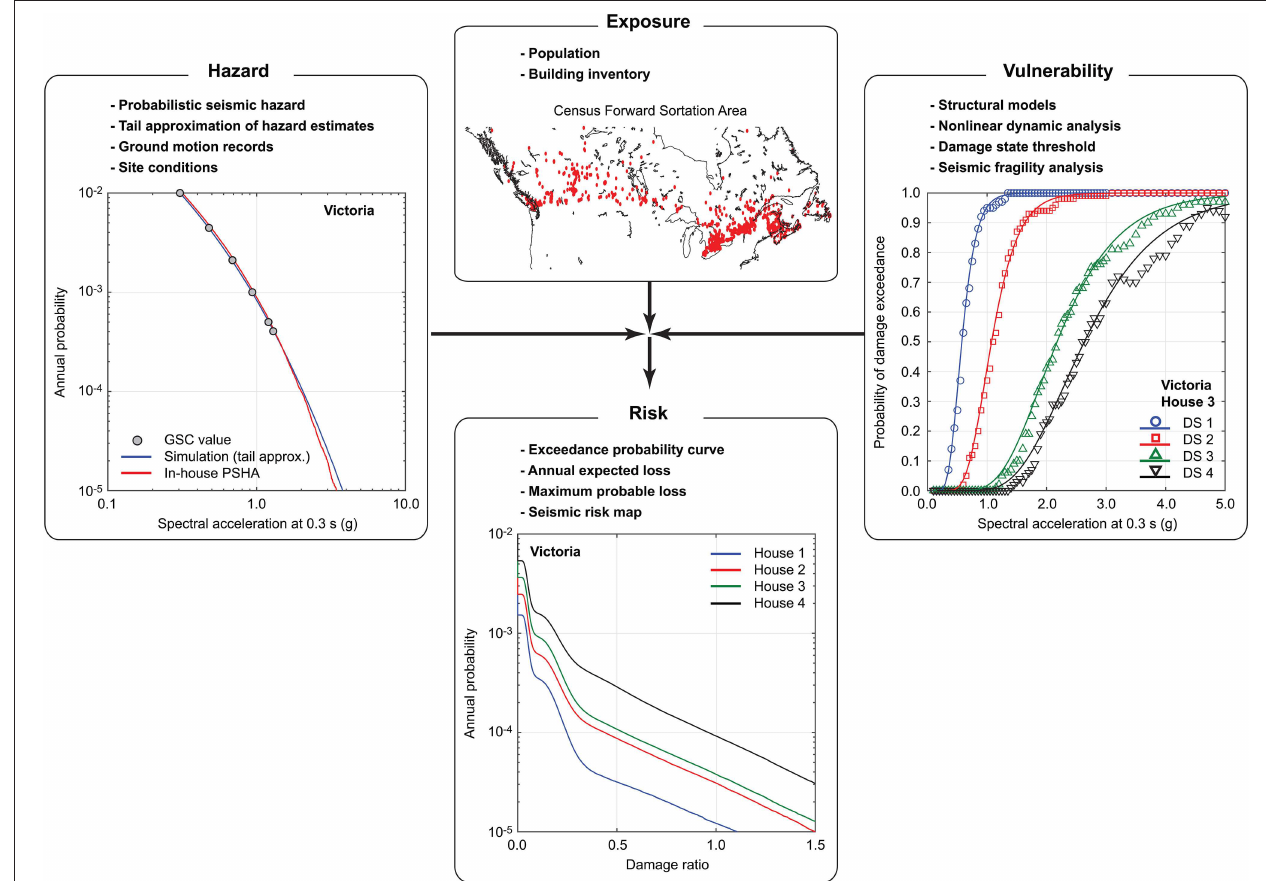
FIGURE 1 | Quantitative seismic risk analysis